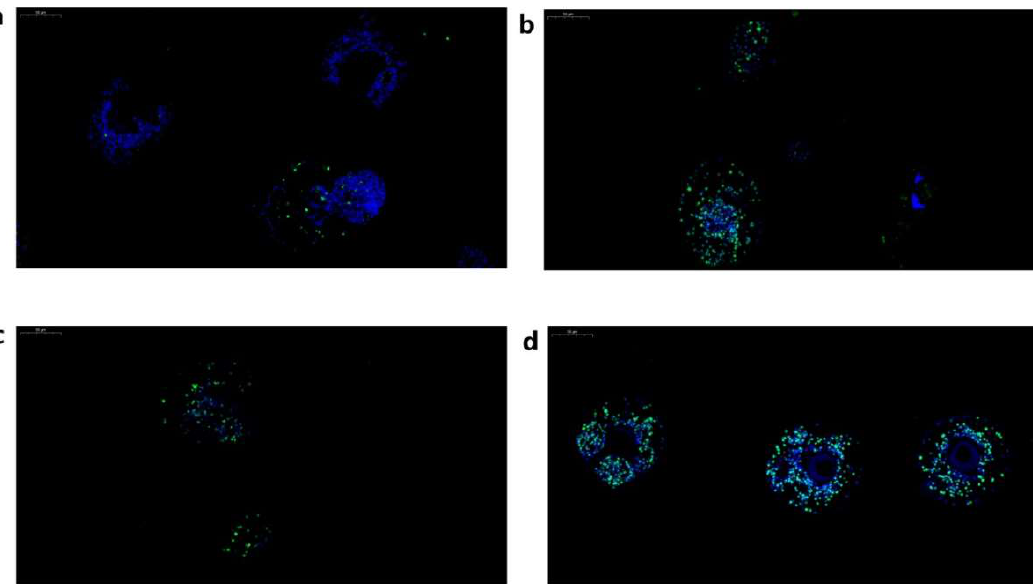
Figure 6. Terminal deoxynucleotidyl transferase dUTP nick end labelling (TUNEL) assay of E. granulosus PSCs following RNA interference (RNAi). ( a ) PSCs in the negative control group (NCG). ( b ) PSCs in the non-interference group (NIG); ( c ) PSCs in the Eg-Fis1 RNAi group (Fis-IG); ( d ) PSCs in the Eg-PDCD6 RNAi group (PDCD6-IG). TUNEL positive cells were stained in green, while negative cells were stained in blue. Table 1. Apoptosis rate of PSCs determined by TUNEL